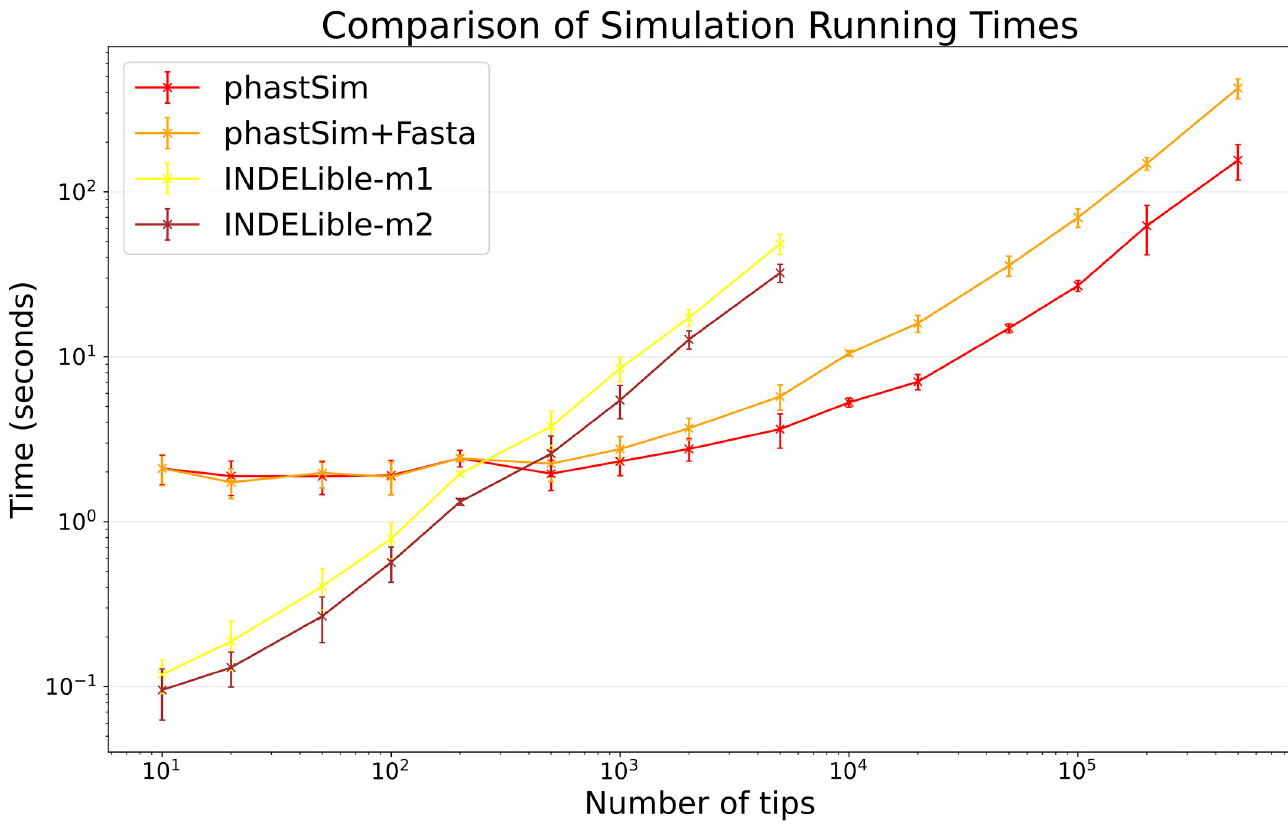
Fig 6. Comparison of running times of Indelible and phastSim simulators in a SARS-CoV-2 scenario with indels. In this scenario we compare phastSim against Indelbile-m1 and Indelible-m2 (the only other methods considered here that model indels). Each value represents ten replicates.